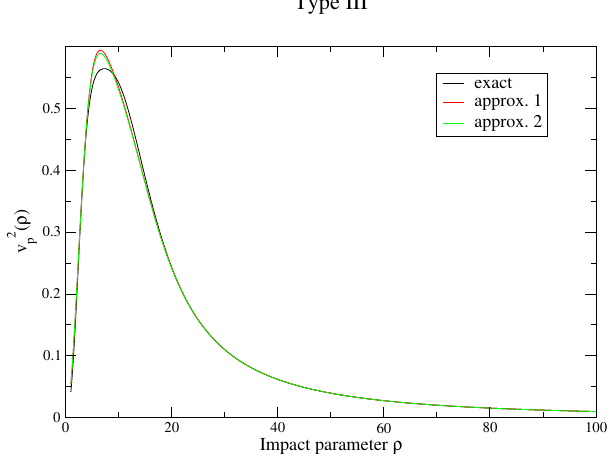
Figure 7. Comparison between the exact computation of v 2 p ( ρ ) and the approximate expressions v p,app1 (see Equation (63)) and v p,app,2 (see Equation (68)) for n α = 4, (cid:96) α = 3, m α = 2, (cid:96) α (cid:48) = 2, and m α (cid:48) = 1, n β = 3, (cid:96) β = 2, m β = 2, (cid:96) β (cid:48) = 1, and m β (cid:48) = 1 (Type II).